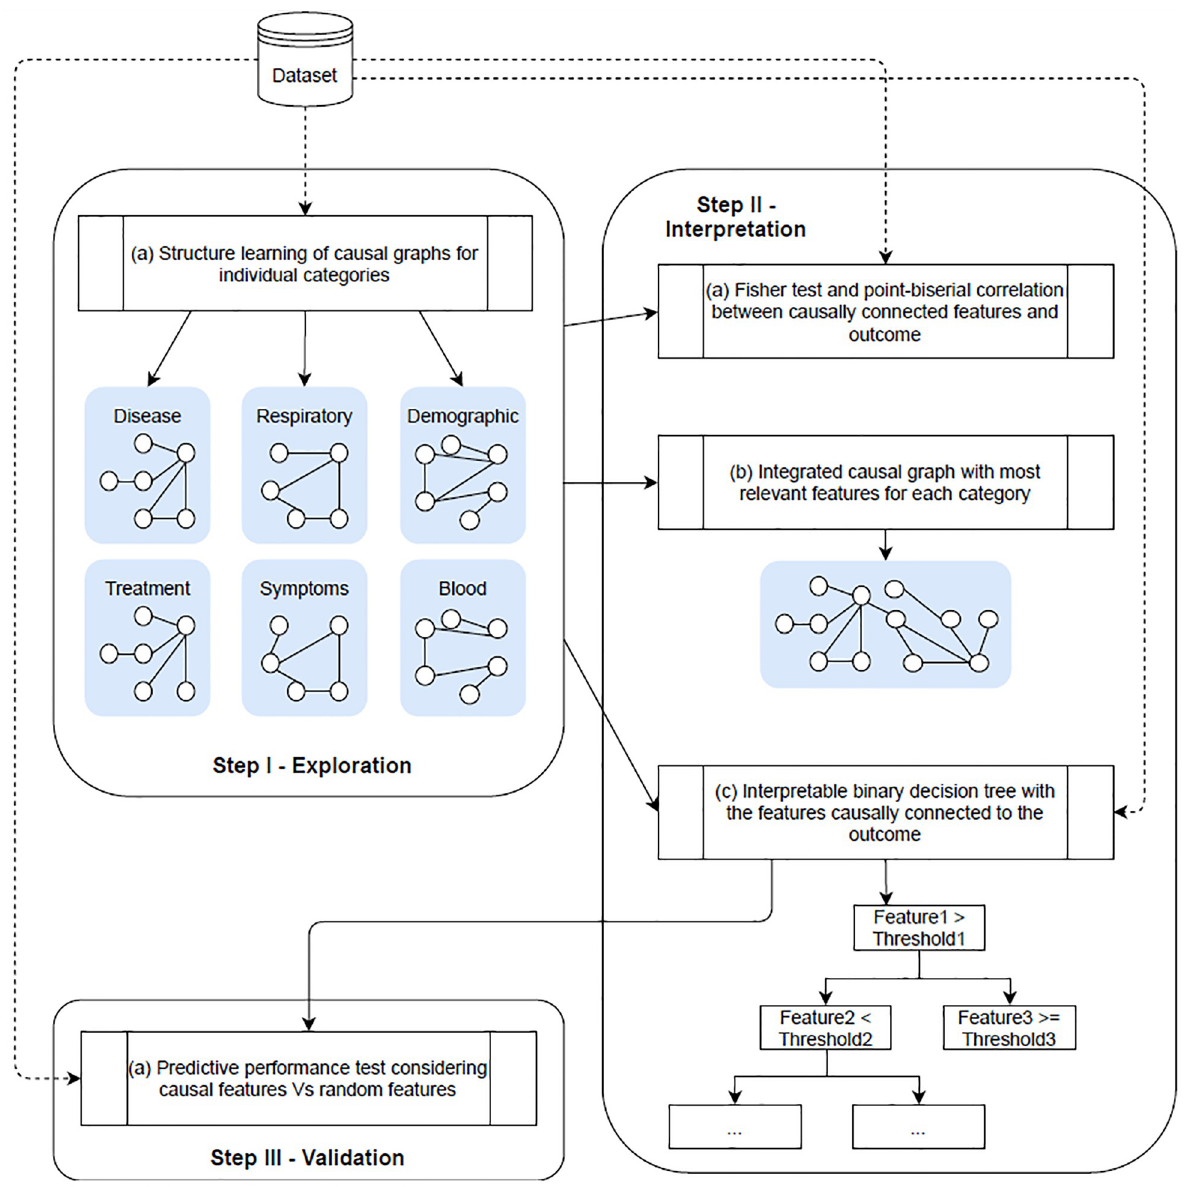
Fig 1. Flow chart of the proposed approach. Our empirical analysis is mainly based on three steps: (1) an explorative analysis applied to different classes of features separately; (2) an integrative and interpretative step; (3) a quantitative validation.